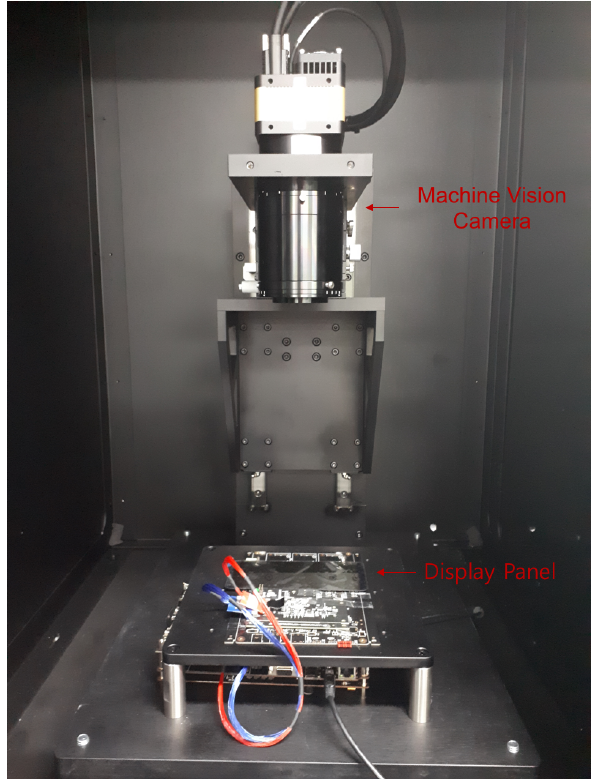
Figure 3. Image acquisition